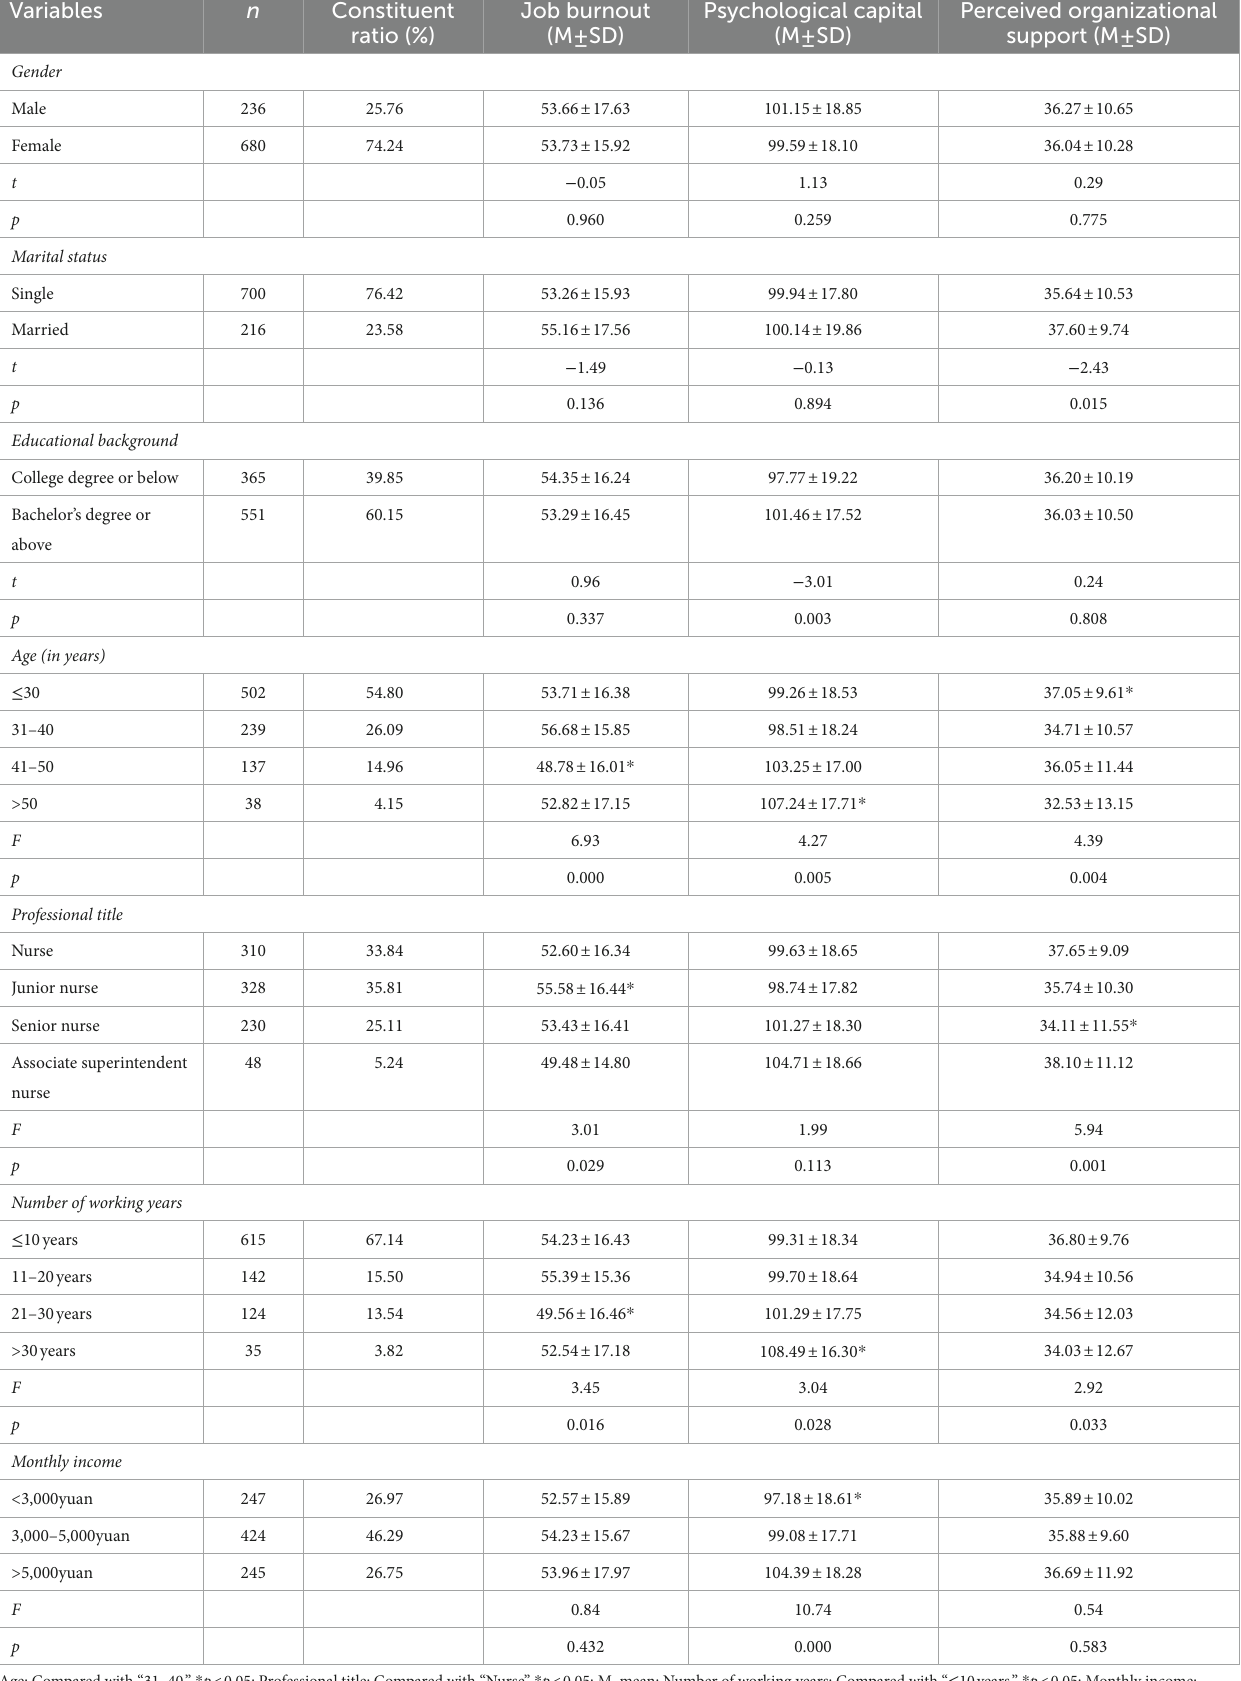
TABLE 1 Univariate analysis of psychiatric nurses’ job burnout, psychological capital, and perceived organizational support ( n = 916, Shandong, China). Variables n Constituent